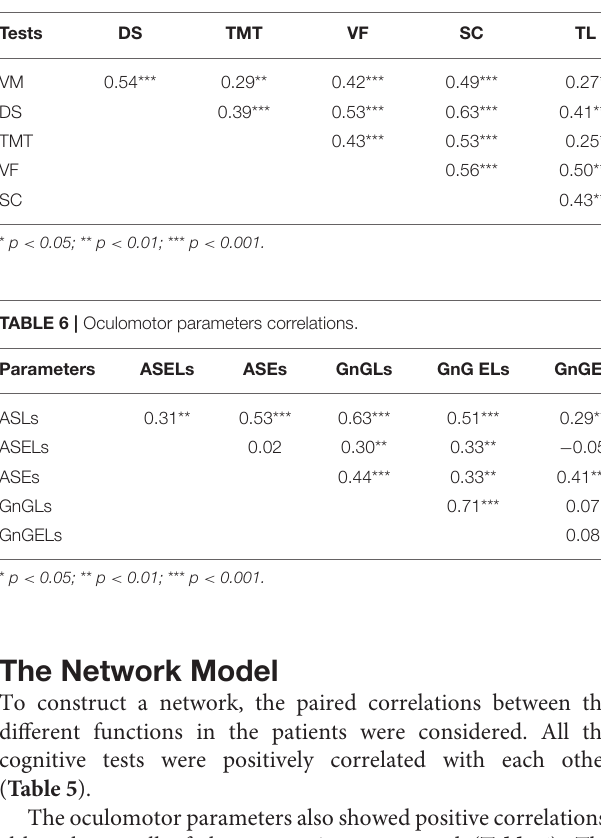
TABLE 5 | Cognitive tests correlations.